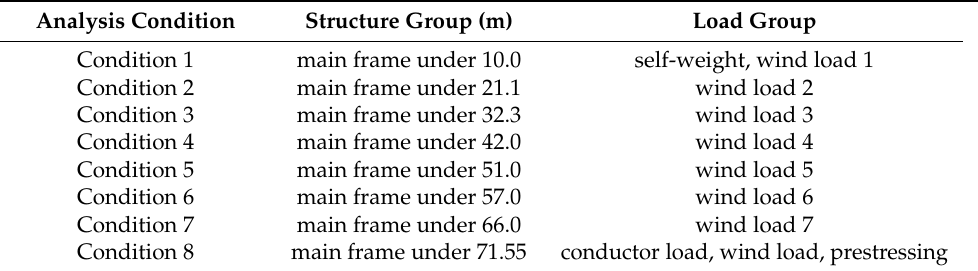
Figure 5. Tower leg main material and foundation simulation analysis measurement point arrangement. Table 3. Transmission-line tower analysis working